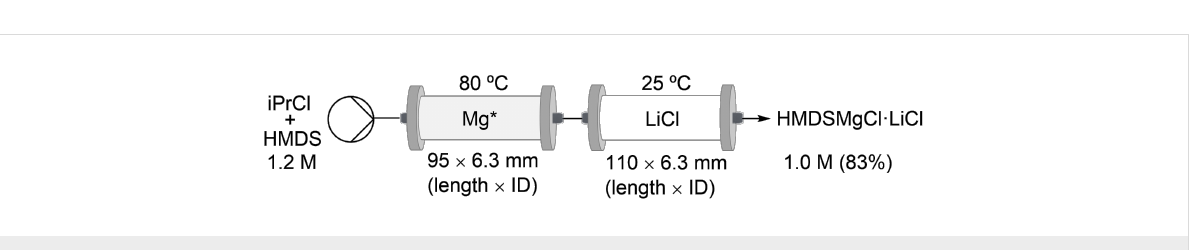
Figure 6: Steady-state concentration stability during the conversion of iPrCl in THF (56 mL, 2.2 M) into iPrMgCl·LiCl (50 mL, 1.91 M) using two perflu- orinated disposable monocomponent tubular reactors.